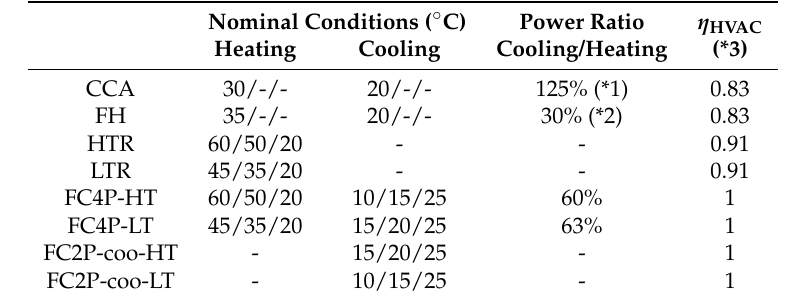
Table 3. Parameters of emission components (component abbreviations are explained in Table 1). Nominal conditions are given as T s / T r / T a with T s , T r and T a the supply, return and zone air temperatures. The power ratio column indicates the ratio between cooling and heating powers for reversible systems and the last column introduces a correction factor ( η HVAC ) for the energy use of the emission system to represent the suboptimality of its control.